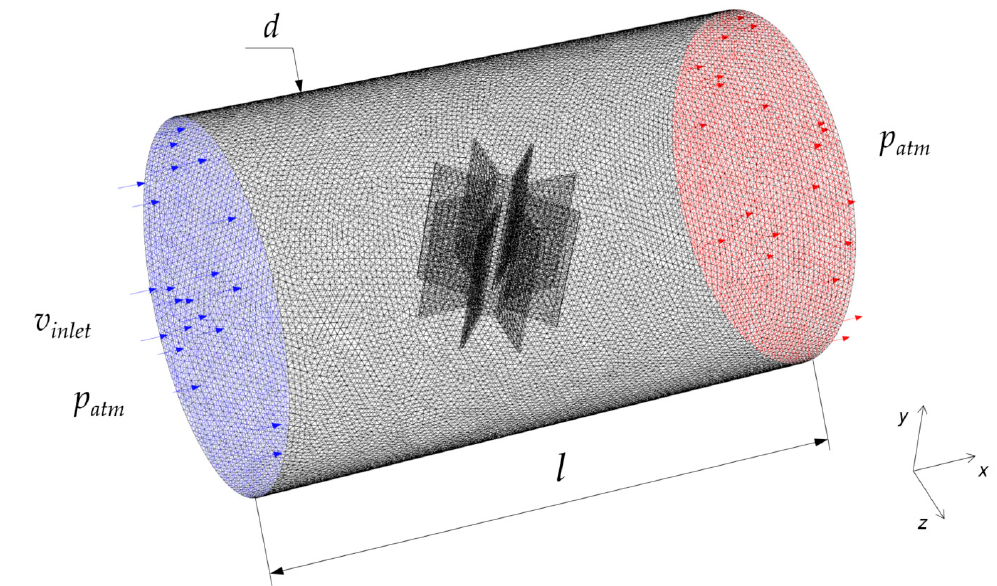
Figure 7. Discretized model with boundary conditions for the case c5.